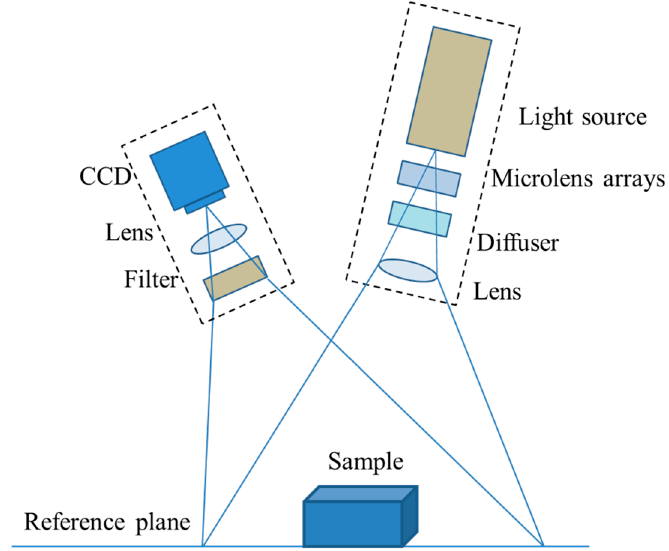
Figure 2. Optical configuration for 3D surface profilometry.